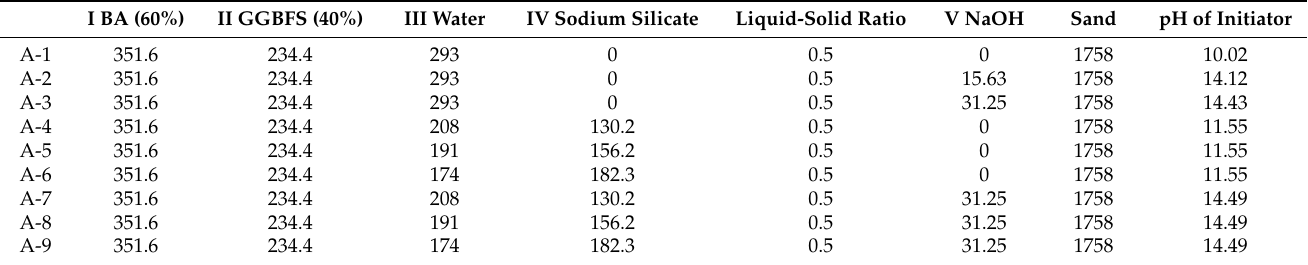
Table 2. Mix proportion of samples (kg/m 3